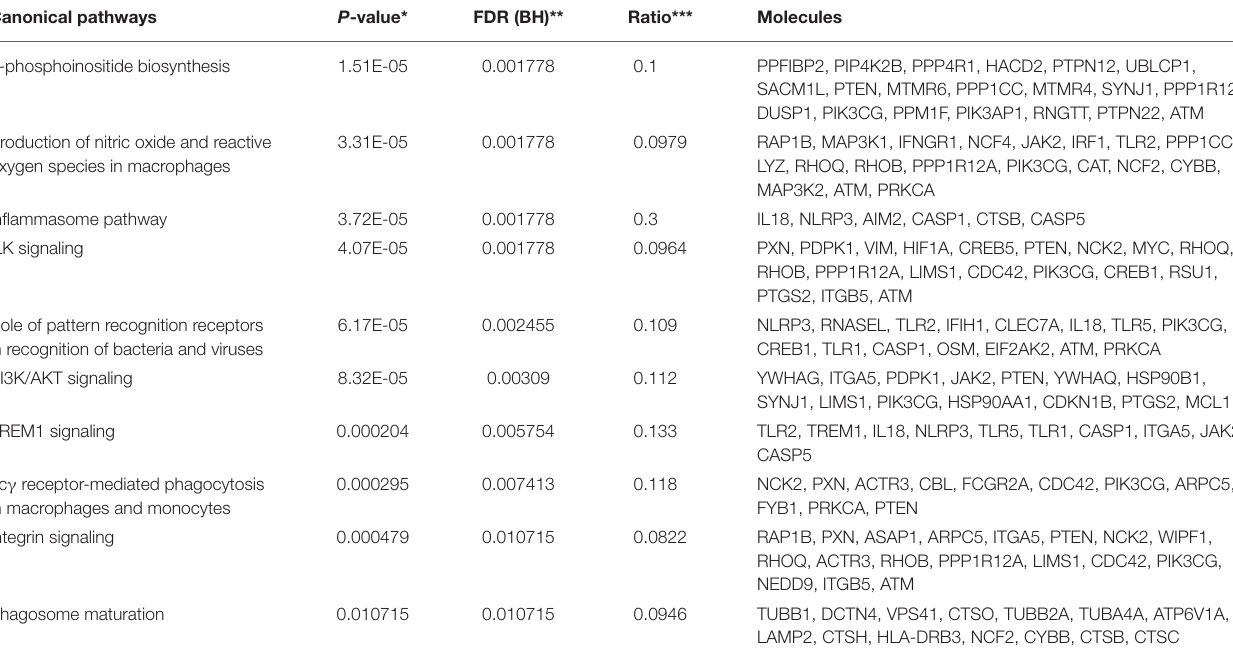
TABLE 5 | Top 10 up-regulated pathways in acute appendicitis patients vs. controls with non-specific abdominal pain. Canonical pathways